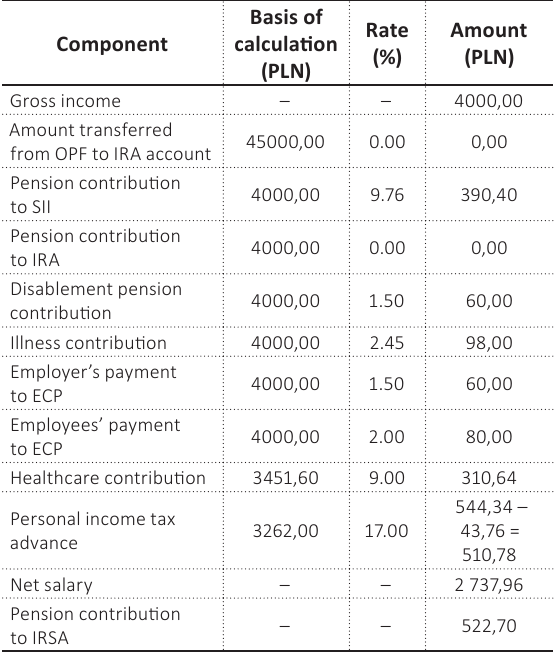
Table 6. Variant 1 – pension amounts after retirement